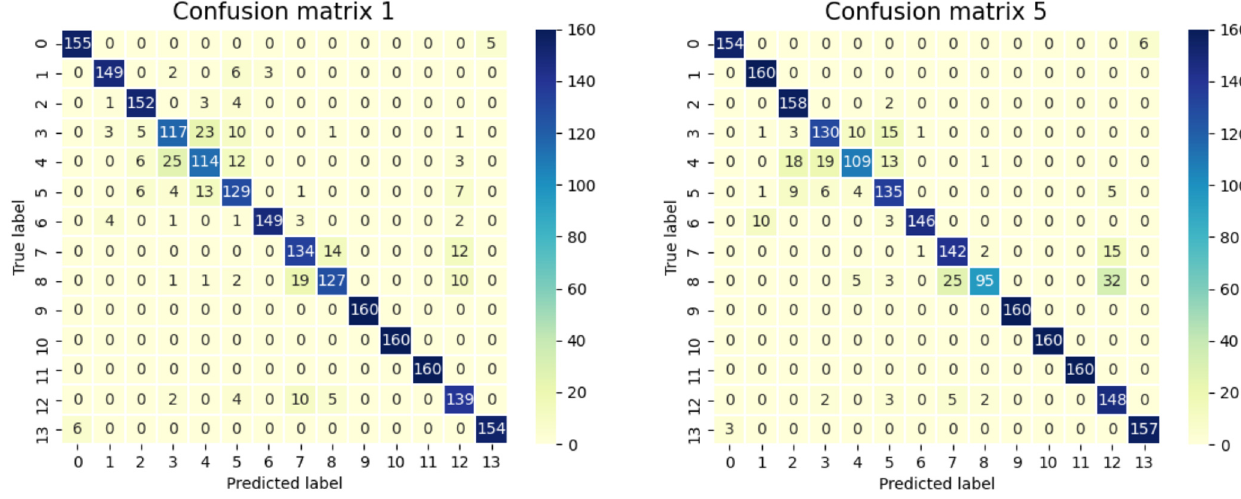
Figure 23. Confusion matrices of two neural networks designed to recognize the 14 failure cases.